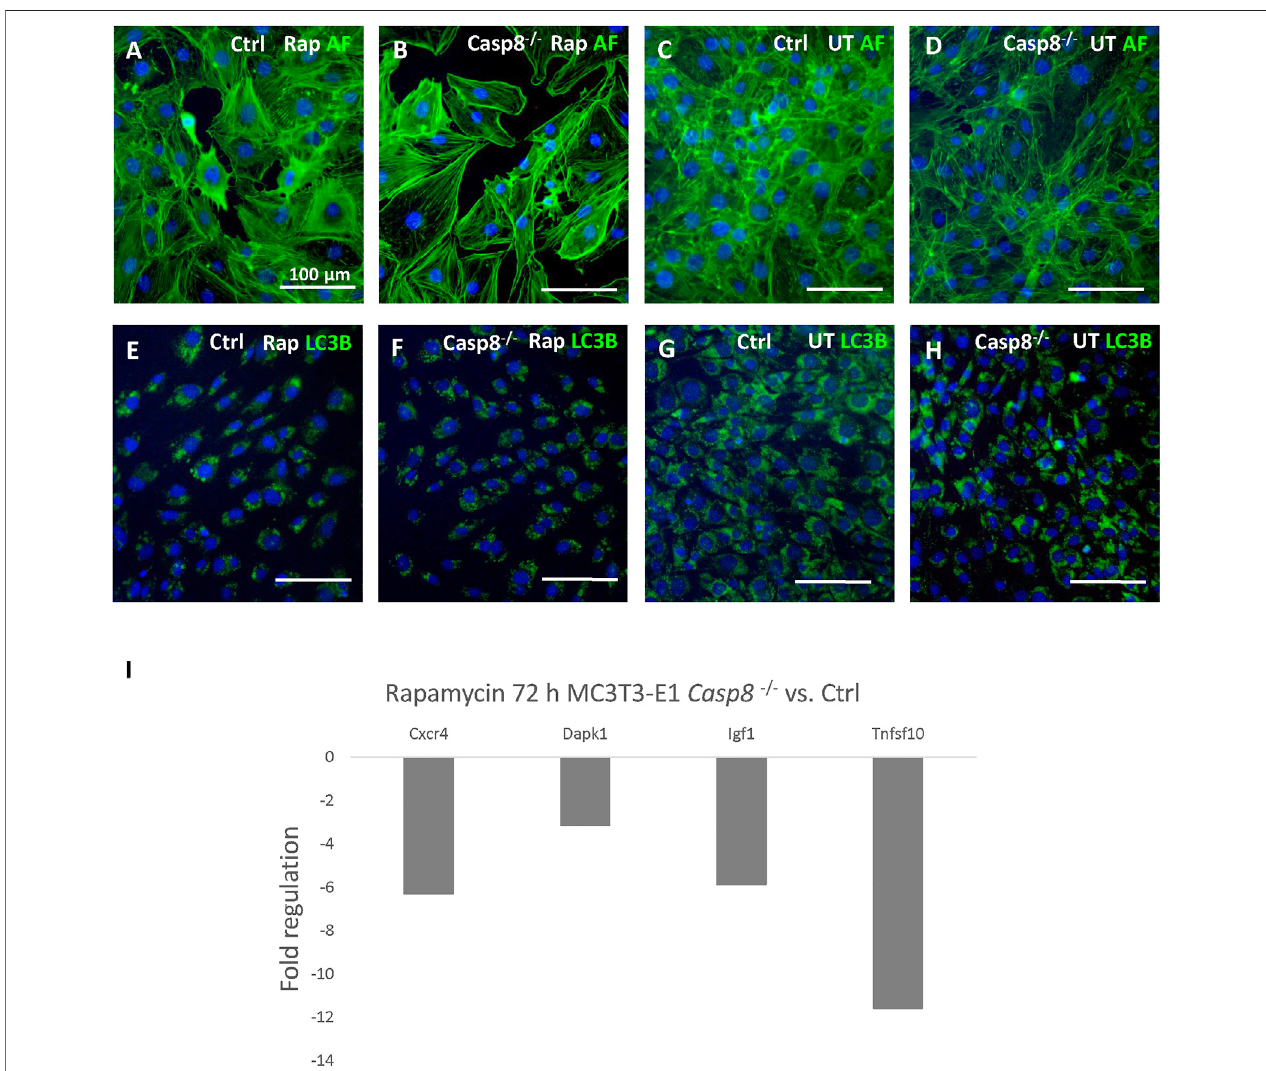
FIGURE 4 | Staining of actin fi laments (green) of control and Casp8 − / − cells after rapamycin treatment compared to untreated controls (A – D) . Staining of LC3B (green) in arti fi cially accumulated autophagosomes in control and Casp8 − / − cells after rapamycin treatment compared to untreated controls (E – H) . Autophagosomes accumulation was induced by chloroquine. Nuclei counterstained by DAPI (blue). Scale bar = 100 µm. PCR Array analysis of autophagy-related gene expression after 72 h of rapamycin treatment in Casp8 − / − compared to control cells (I) . Rap rapamycin, UT untreated.